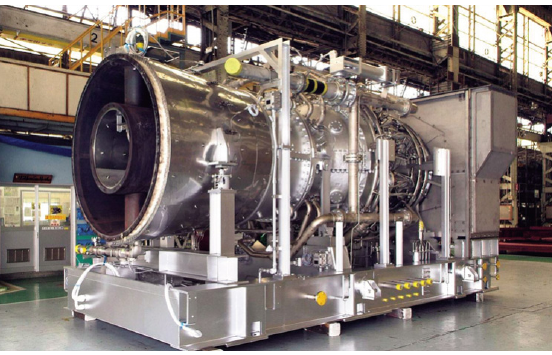
Figure 23. Mitsubishi H-25 series gas turbine [111].